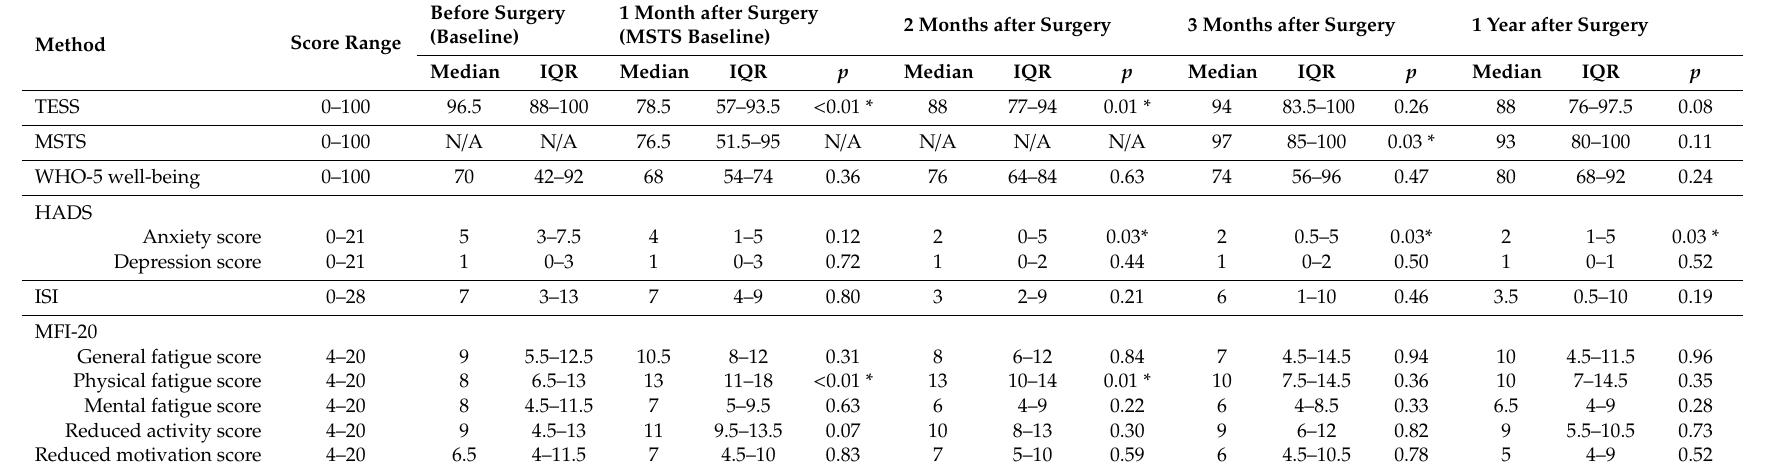
Table 3. Functional outcome and quality of life measured by questionnaires.